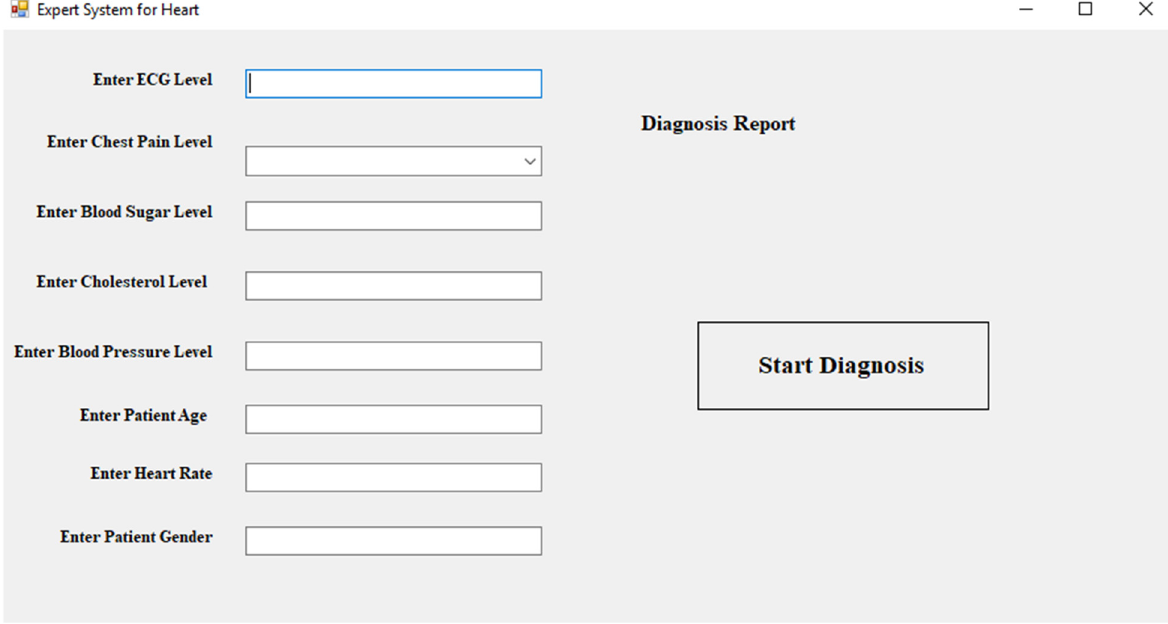
Figure 10. Expert system simulation in C# main interface of the system.